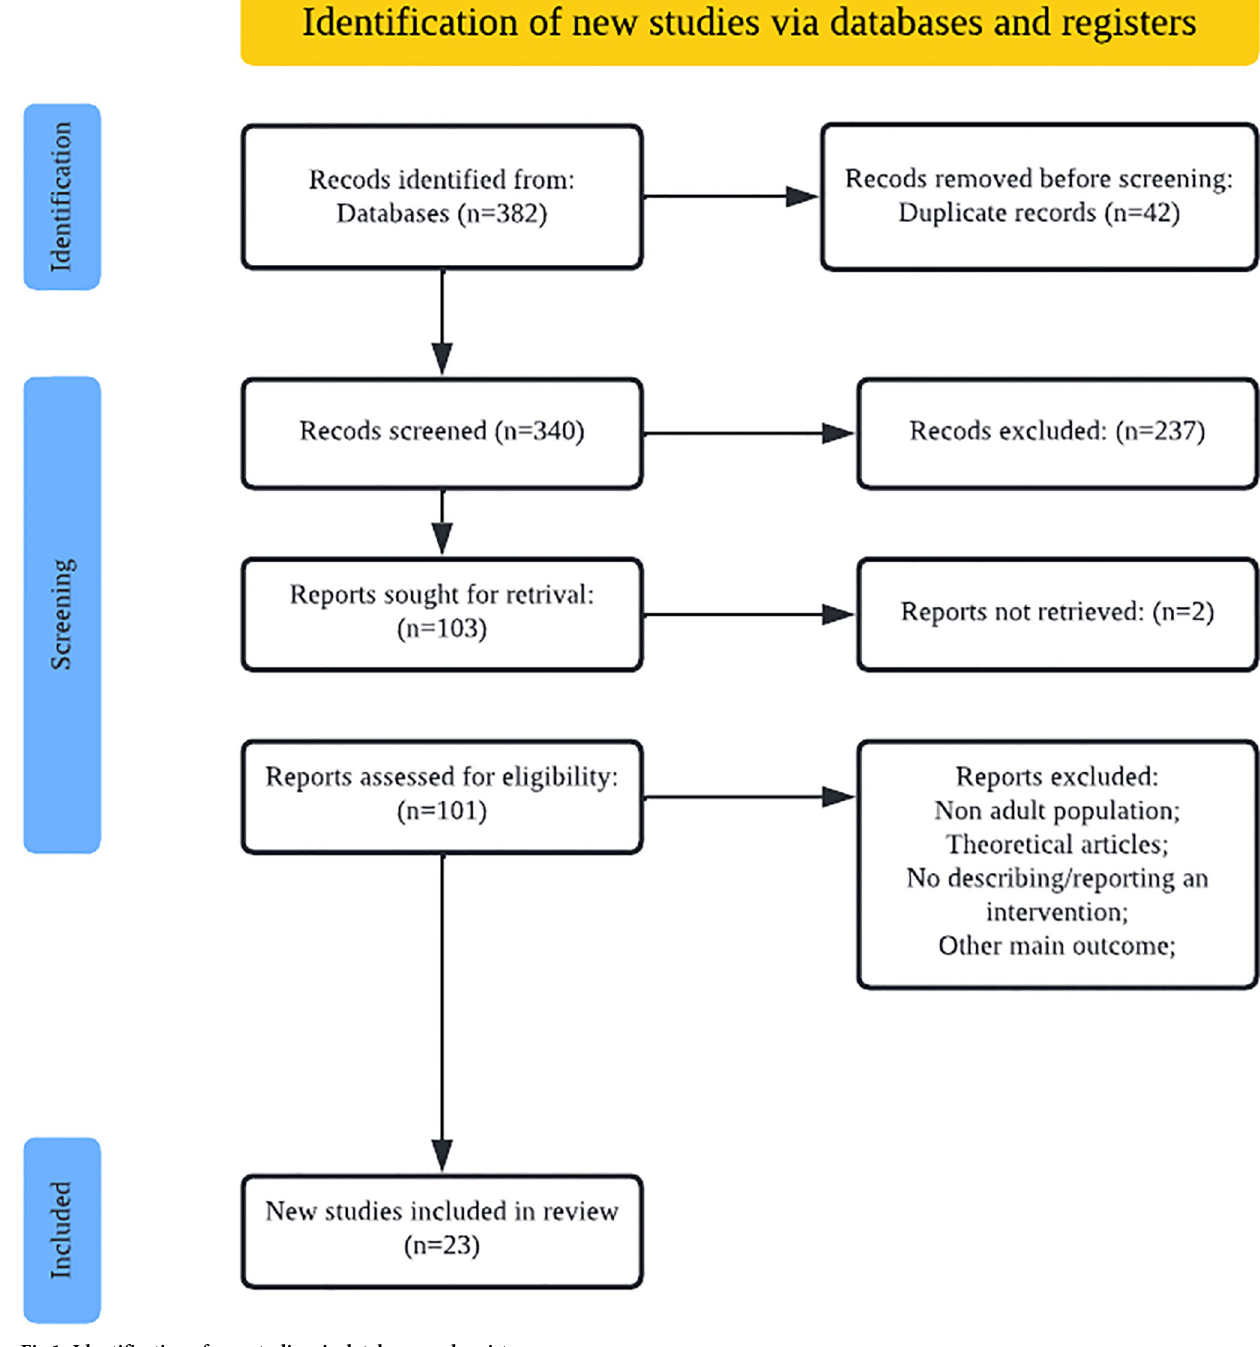
Fig 1. Identification of new studies via databases and